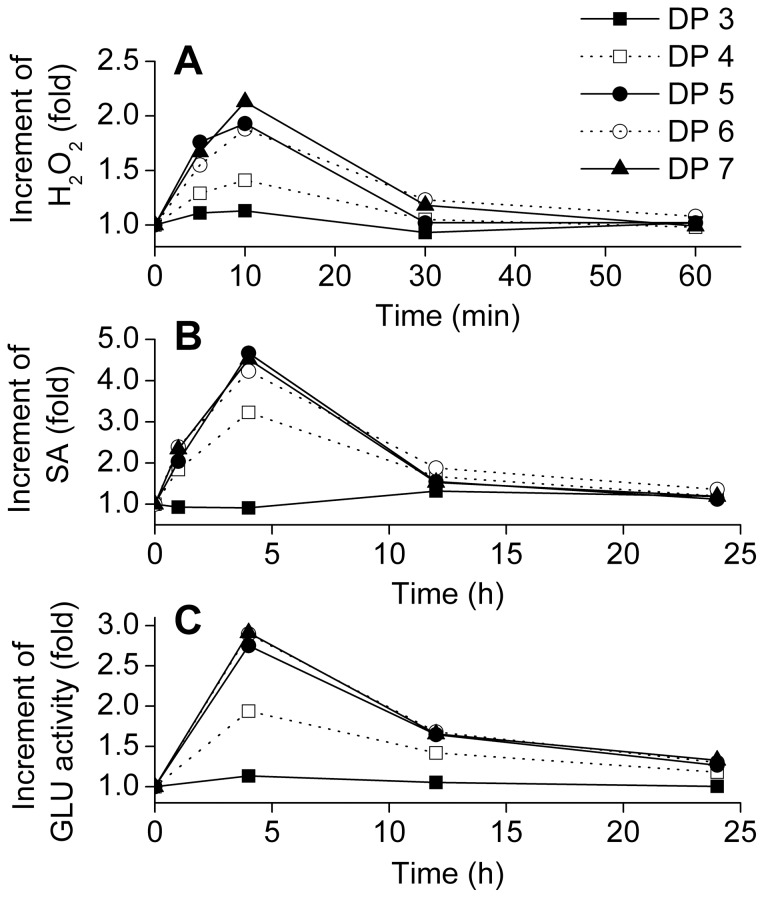
Time-course increment of H2O2, salicylic acid (SA), and β-1,3-glucanase (GLU) in potato leaves treated with curdlan oligosacchrides.The concentration of H2O2 and SA and the activity of GLU were set as 1.0 before elicitation (0 min). The values after elicitation were expressed as the increment of fold(s) comparing with the values before elicitation. The curdlan oligosaccharides used in this experiment have the degree of polymerization (DP) from 3 to DP 7. All the tests were performed in triplicates.